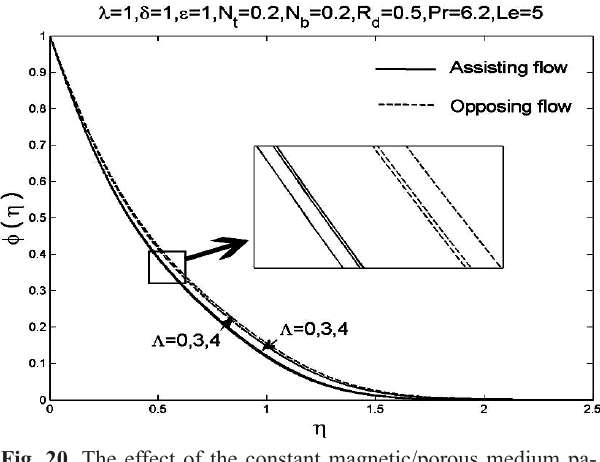
Fig. 20. The effect of the constant magnetic/porous medium pa- rameter Λ on the concentration profiles ( ) φη